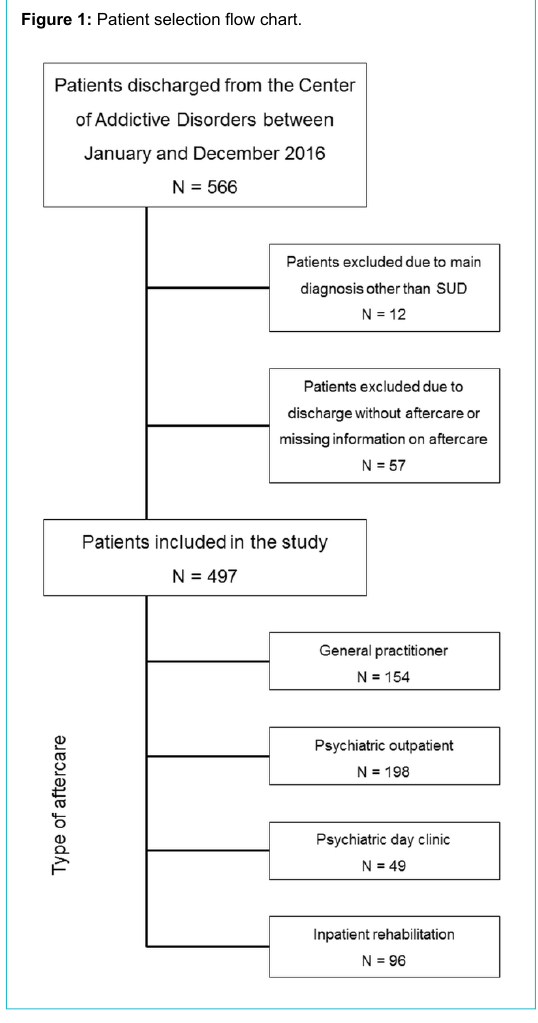
Figure 1: Patient selection flow